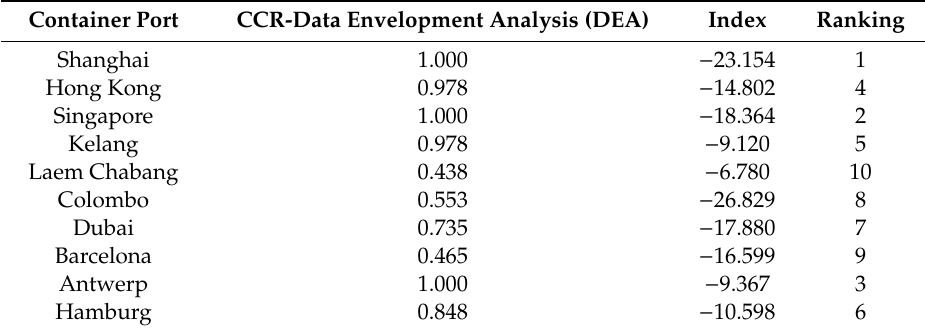
Table 5. Operational e ffi ciencies of the 10 container ports along the